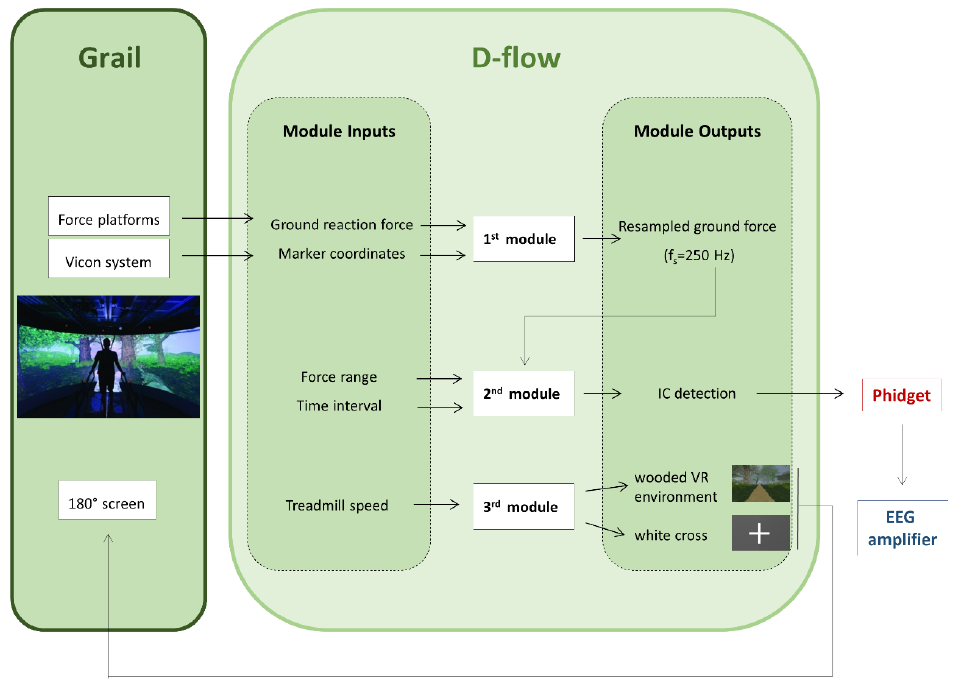
Figure 2. Schematic representation of the software functionalities developed for the EEG-GRAIL system integration. Inputs and outputs to each Script module are